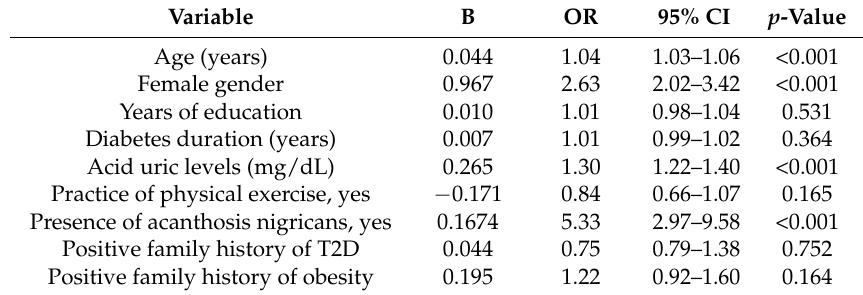
Table 2. Predisposing factors to metabolic syndrome, accessed by binary logistic regression.